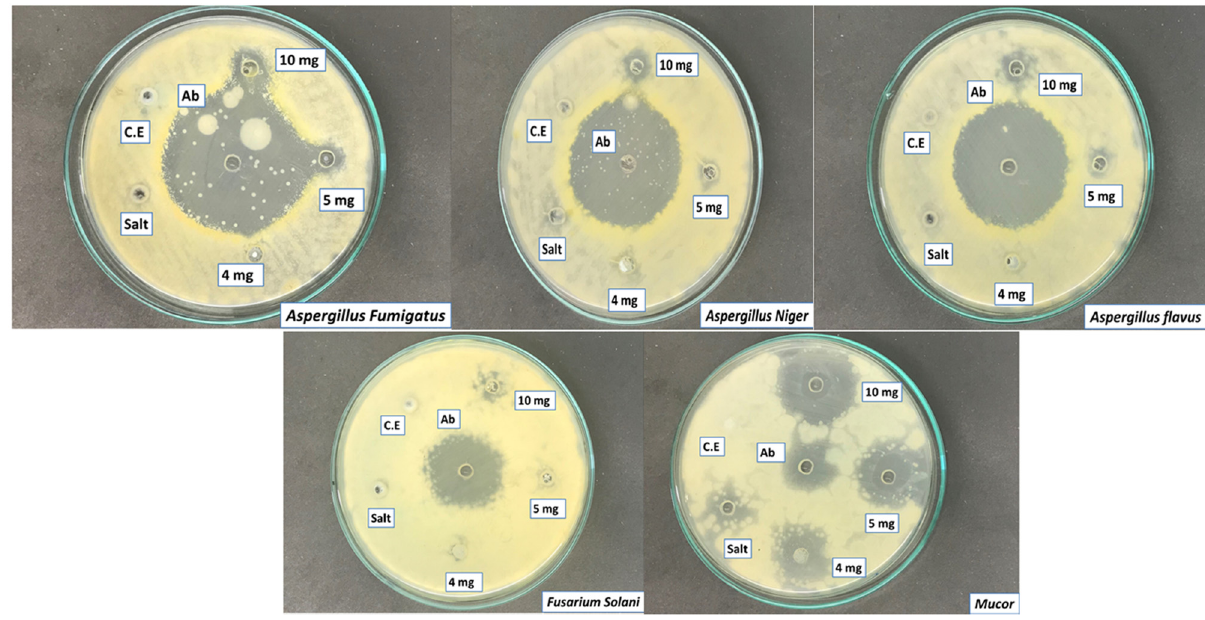
Figure 11: Antifungal activity of ZnO - NPs against fi ve di ff erent fungal strains at di ff erent concentrations ( 10, 5, and 4 mg · mL − 1 ) ; Ab – antibiotic, CE – callus extract.